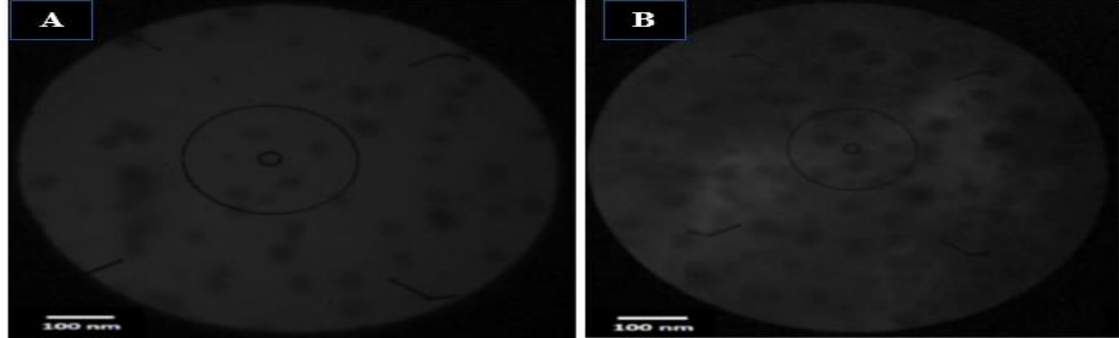
Figure 4. TEM of (A) APX-NE and (B) APX-NE gel. Ex Vivo APX-NE gel permeation study Human abdominal skin of adult female utilized for APX-NE gel permeability assessment to get best fit with in vivo conditions using Franz cell apparatus. Figure 5 present cumulative amount of APX permeated through human stratum corneum